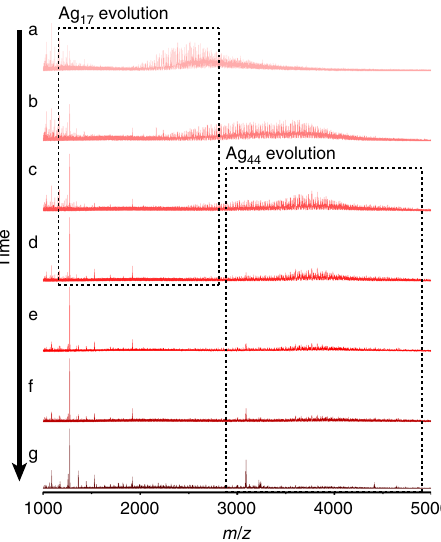
Fig. 3 Time-dependent ESI-MS spectra. The spectra show the evolution of atomically precise thiolate-stabilized Ag nanoclusters in the reaction solution. The rectangles highlight the evolution of the fi nal products, Ag 17 (SPh- t Bu) 12 3 − and Ag 44 (SPh- t Bu) 30 4 − . The capture started as soon as the methanol was added and the reaction time in each panel was a 0 min, b 2 min, c 4 min, d 7 min, e 10 min, f 15 min and g 25